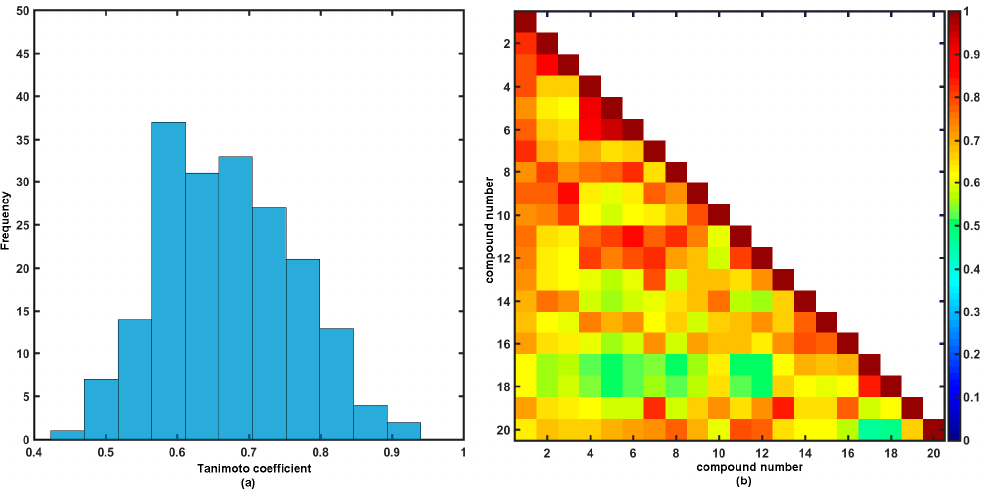
Figure 5. Distribution of Tanimoto coefficients ( a ) and triangular matrix of Tanimoto coefficients ( b ) for 1 – 20 anilides. 1 – 20